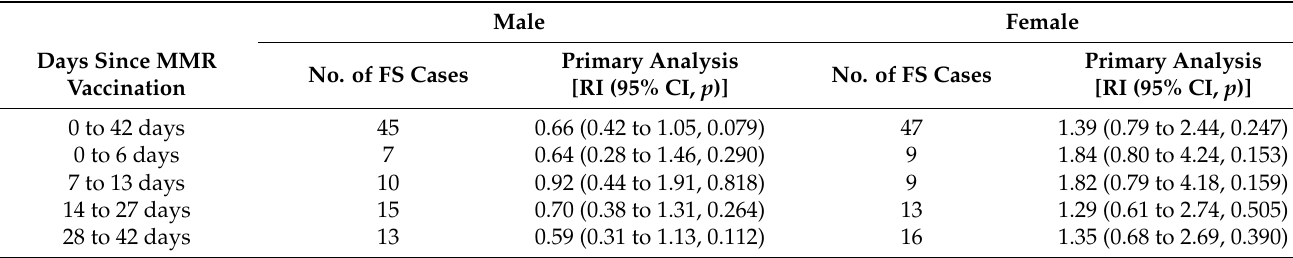
Table 4. Relative incidence of FSs after MMR vaccination by